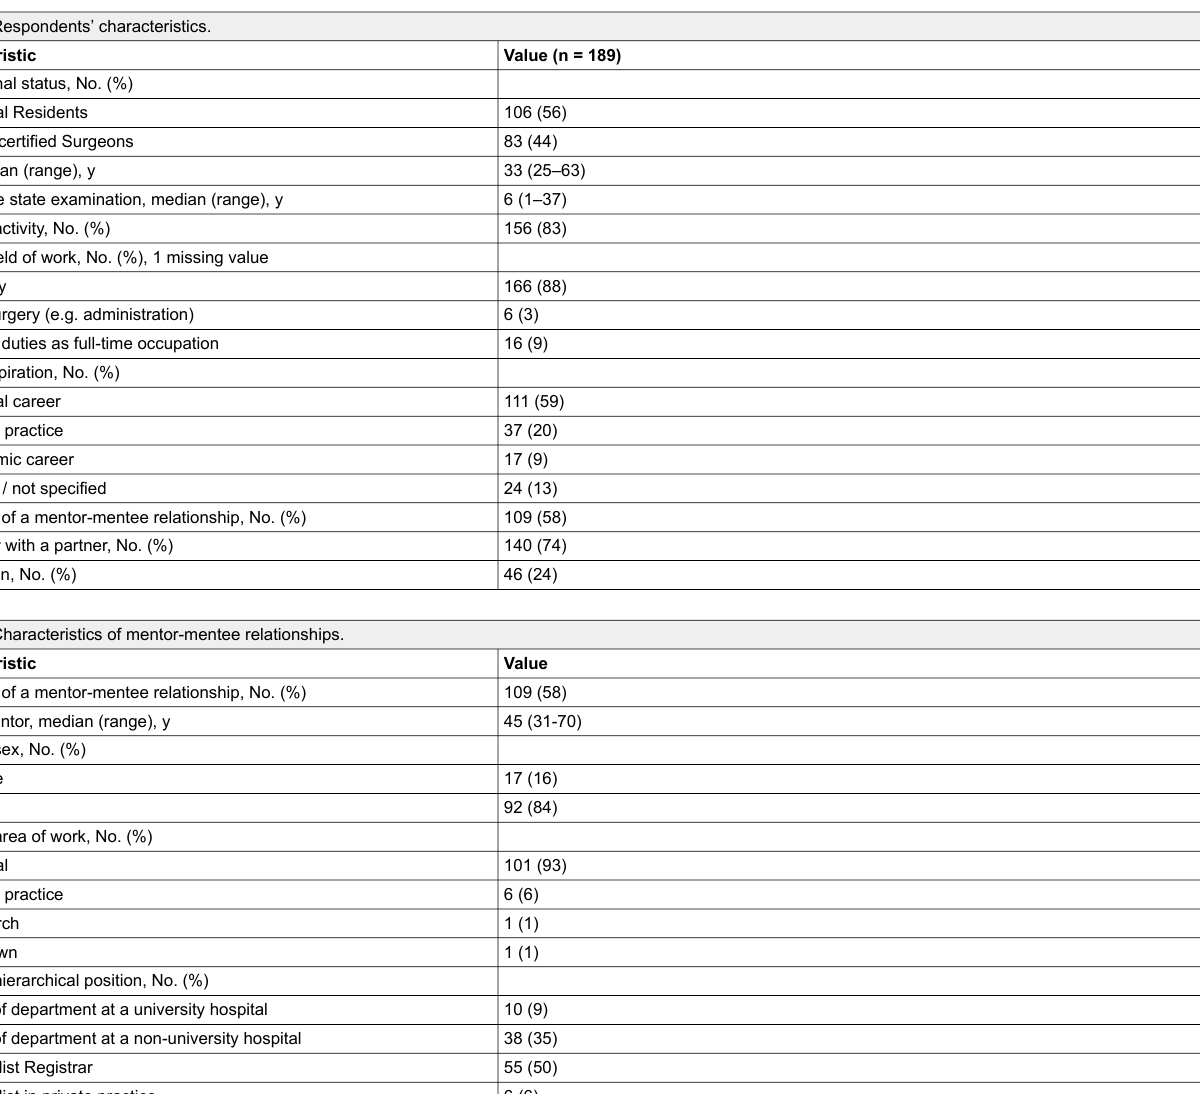
Table 3: Characteristics of mentor-mentee